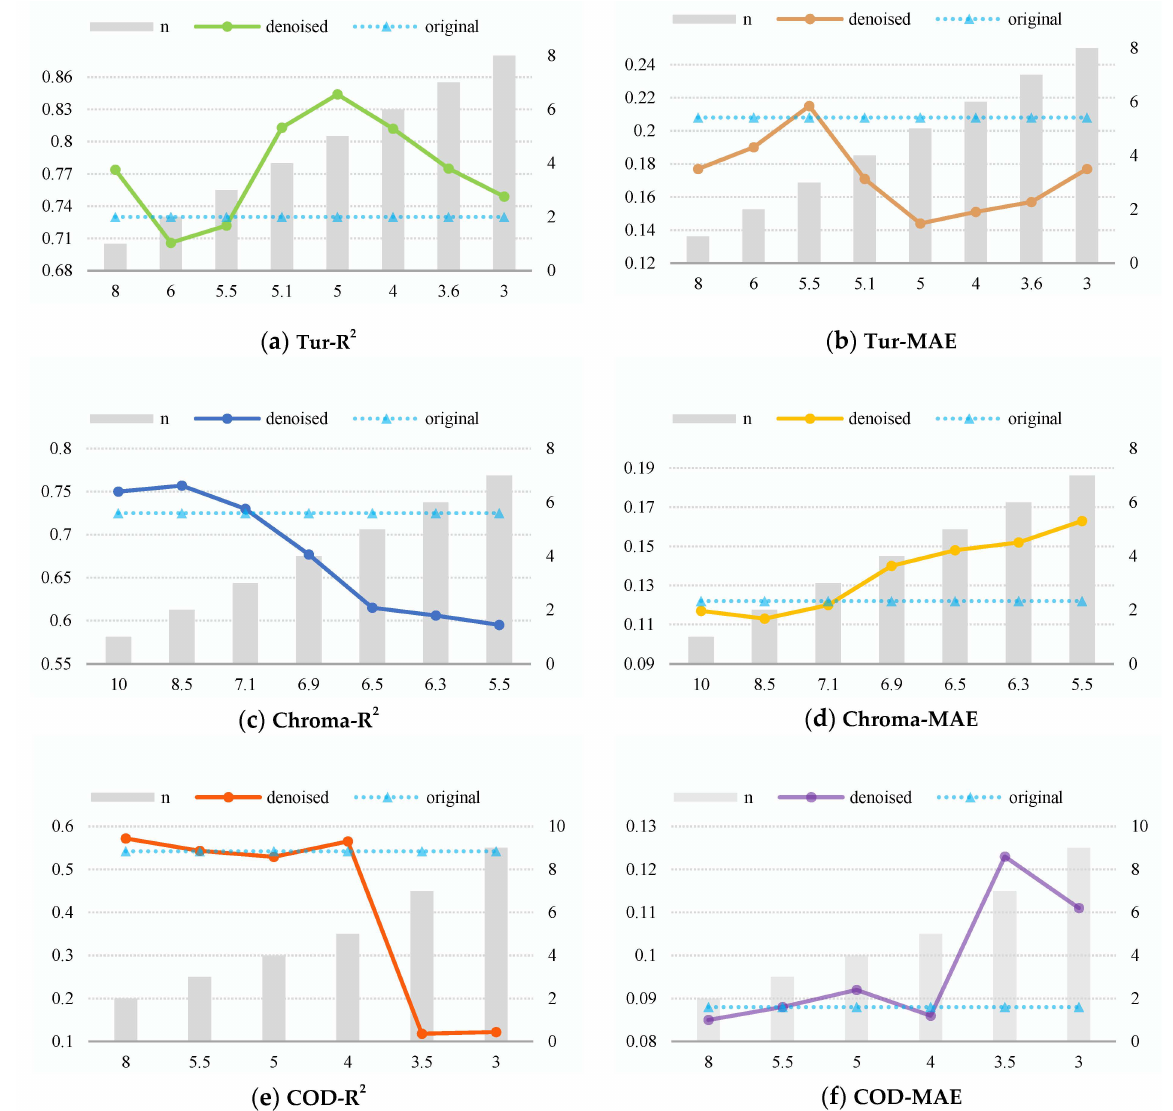
Figure 5. The accuracy results of different parameter value. ( a , b ) represents the R2 and MAE of retrieving Tur. ( c , d ) represents R2 and MAE of retrieving Chroma. ( e , f ) represents R2 and MAE of retrieving